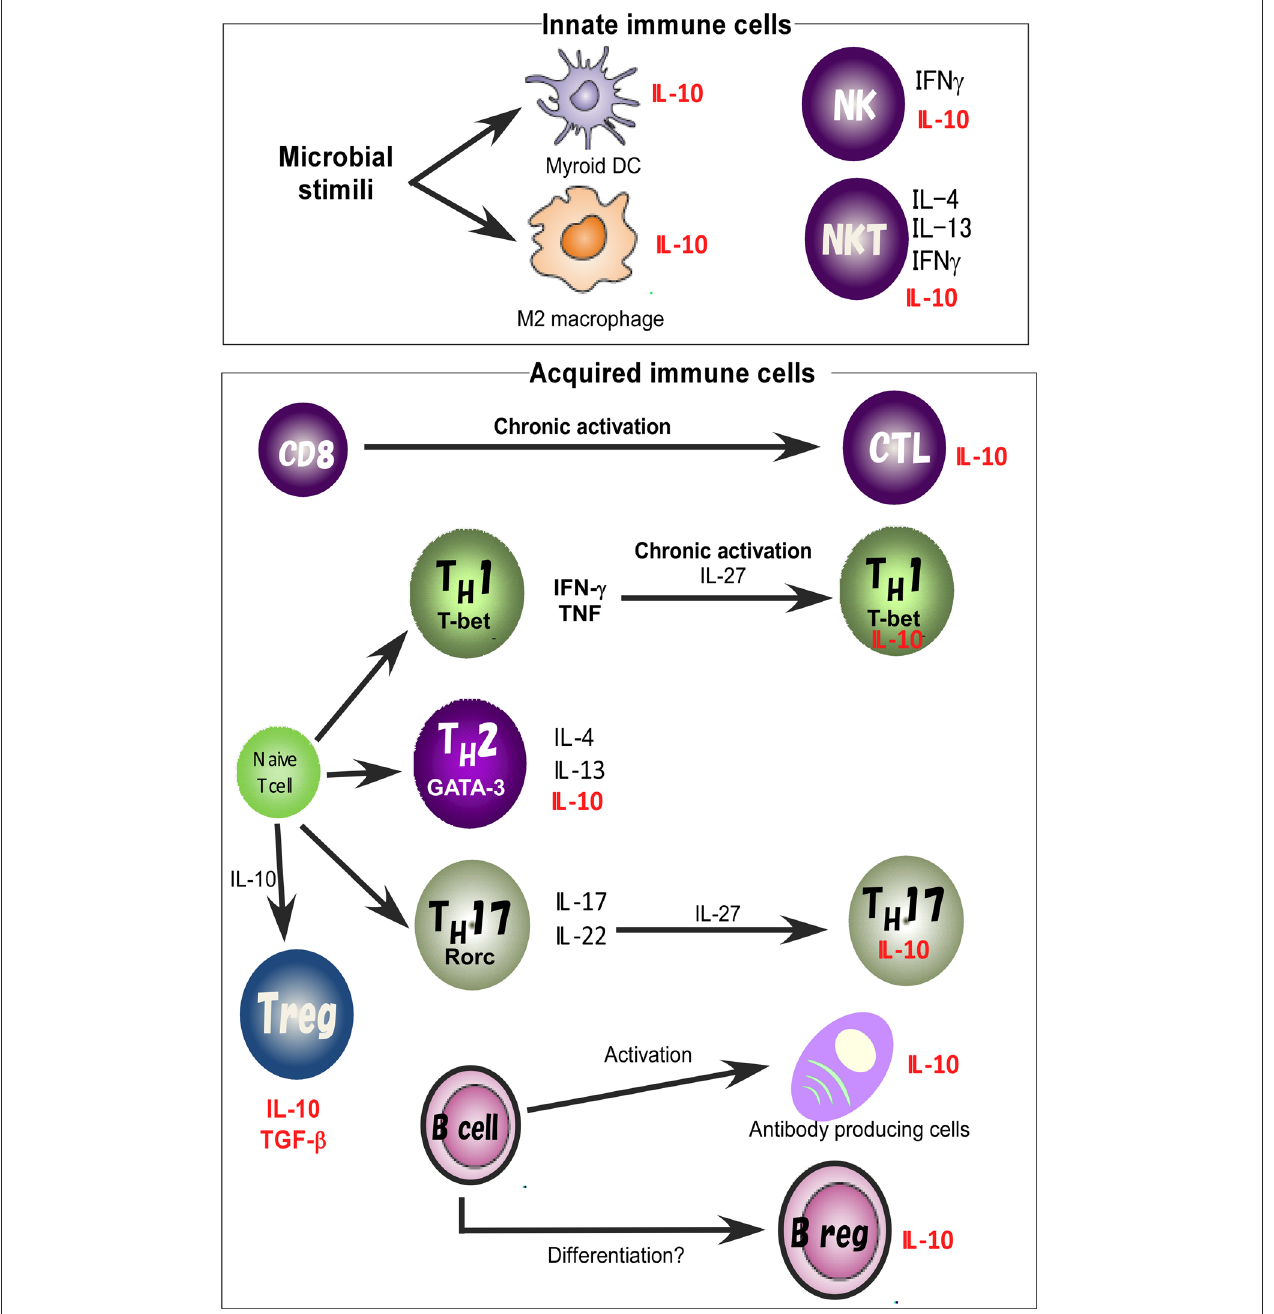
FIGURE 1 | IL-10 expression in the immune system. IL-10 is expressed by M2 macrophages and myeloid DCs. Treg, TH1, TH2, and TH17 cell subsets share the ability to produce IL-10. IL-10 regulates the function and/or IL-10 production of Treg cells. IL-10 production by TH1 cells is induced in